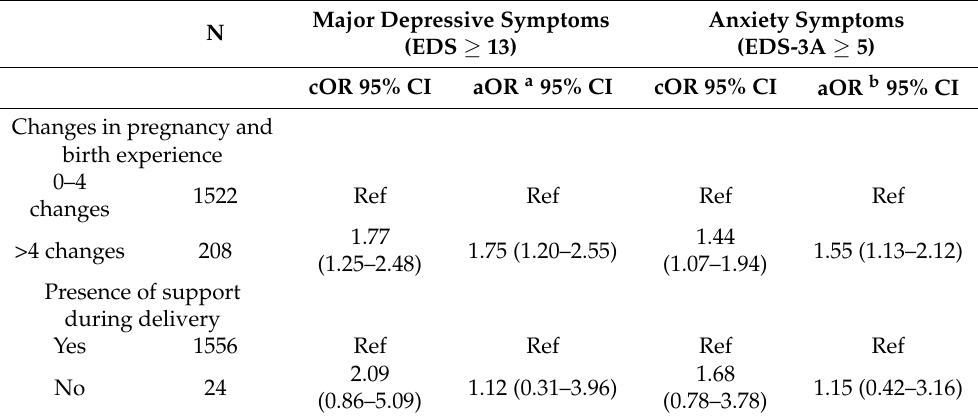
category. a,b Adjusted for country, COVID-19 status, and prior breastfeeding experience. Table 5. Associations between specific pregnancy and birth-related changes and mental health outcomes. Pregnancy and Birth-Related Changes (Yes vs. No, Reference Category: No)